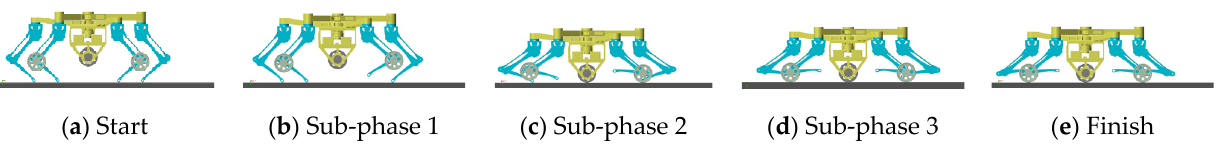
Figure 11. Simulation of leg-to-wheel switching motion using TeCVP.